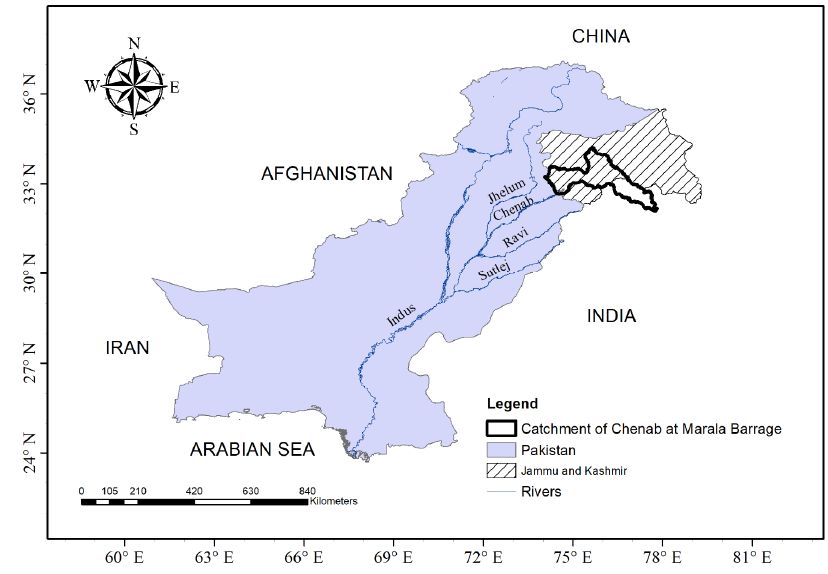
Figure 1. Location map of the Indus basin rivers and the Chenab catchment.